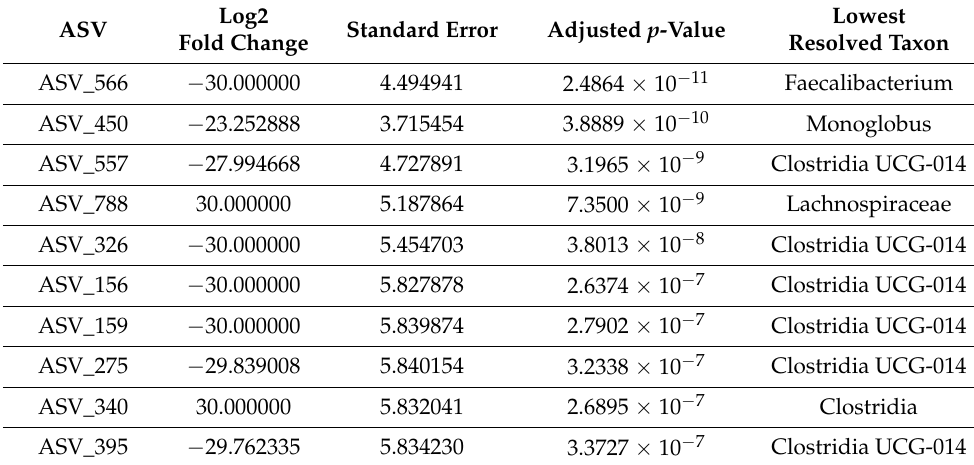
Table 4. Top ten differentially abundant ASVs for the treatment effect based on the adjusted p -value. The direction of differential abundance is indicated by the sign of the Log 2 Fold